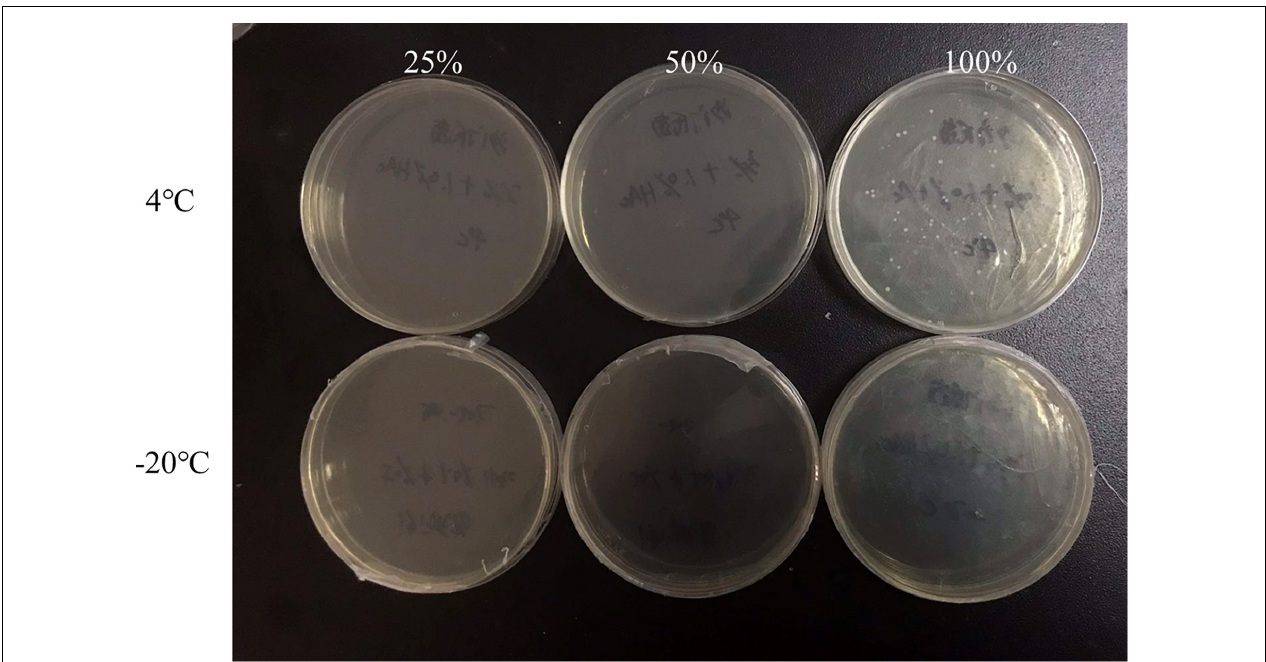
FIGURE 5 | The culturable number of Salmonella inoculated in the 1.0% (v/v) acetate medium containing 100, 50, and 25% nutrients at low temperature for 3 days.